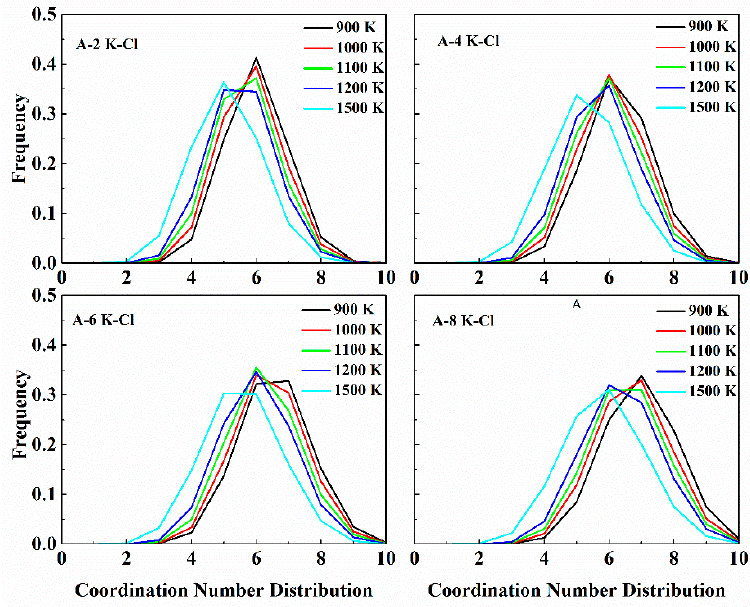
Figure A7. The coordination numbers distribution of four compositions at various temperatures: K- Cl.